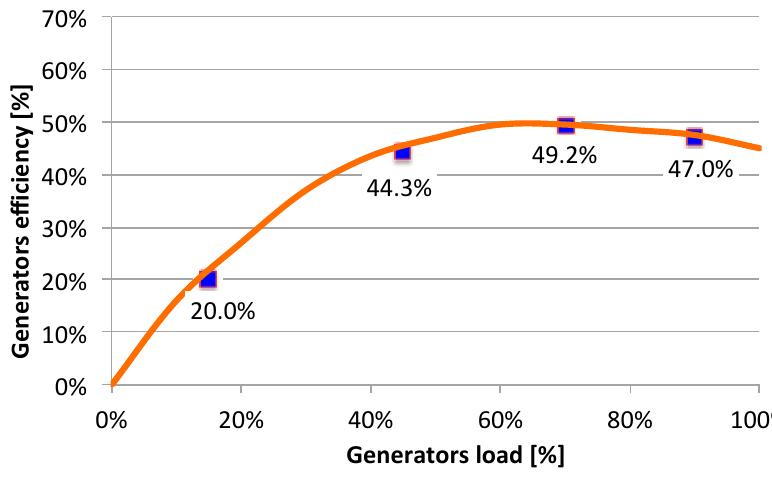
Figure 8. Diesel generators efficiency vs. load estimated trend and piecewise averaging (The figure was elaborated by the authors based on data provided by SMEDE [80]).